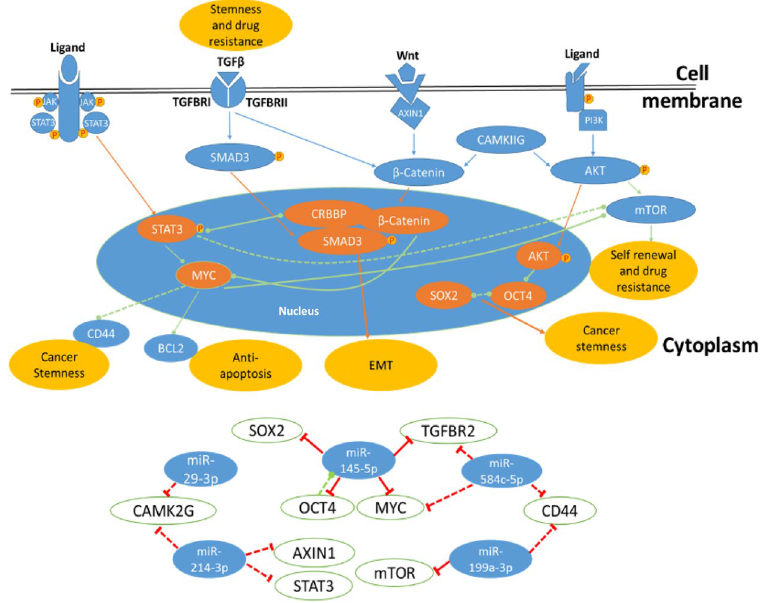
Figure 5. The proposed model of the interacted HCSC pathways regulated by the selected miRNAs and TFs. Solid lines are the experimentally validated, while dashed lines are the predicted correlations. Red lines are directed from miRNA, while green lines directed from TF to their